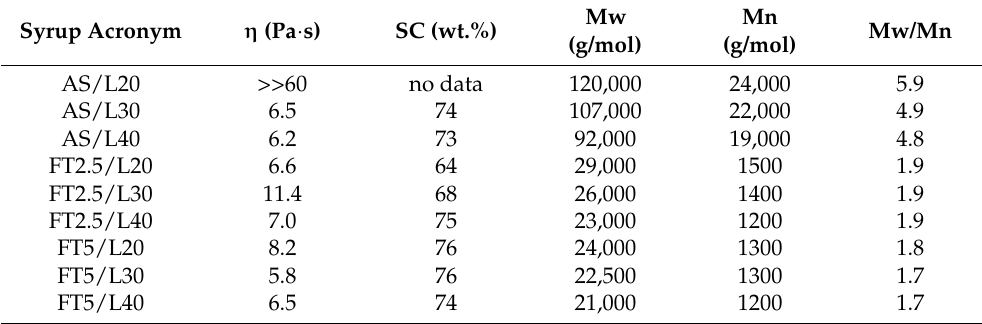
Table 2. Dynamic viscosity and solids content of the fluorotelomers and acrylic syrups, as well as the molecular weights of the fluorotelomers and acrylic copolymers.